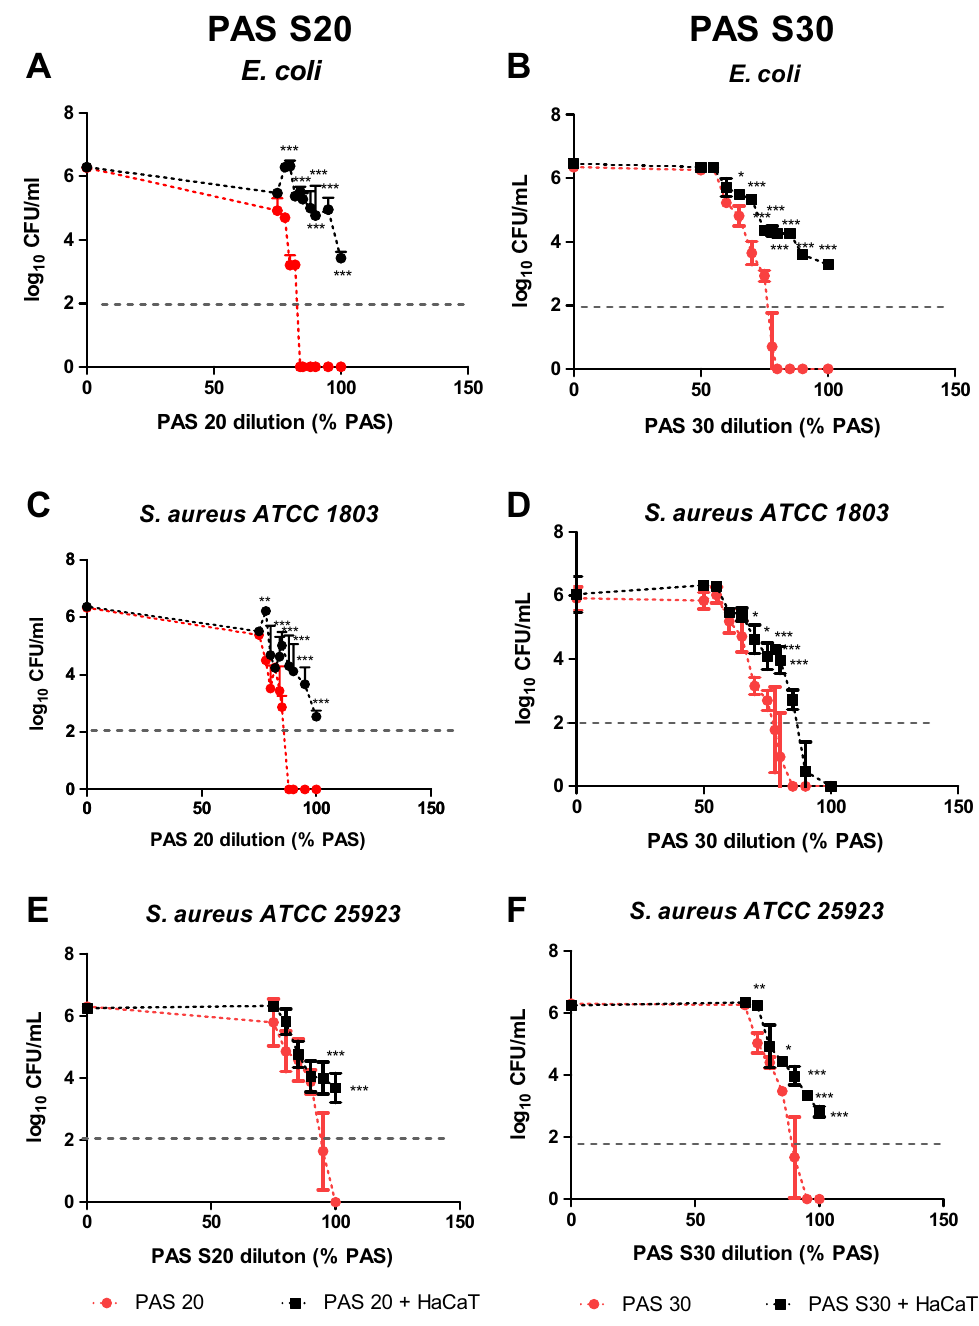
Figure 4. The antimicrobial efficacy of PAS 20 and PAS 30 within the co-culture model between HaCaT cells and E. coli or S. aureus and incubation with diluted PAS 20 or PAS 30 after 60 min contact time. ( A ) E. coli —PAS 20, ( B ) E. coli —PAS 30, ( C ) S. aureus ATCC 1803—PAS 20, ( D ) S. aureus ATCC 1803—PAS 30, ( E ) S. aureus ATCC 25923—PAS 20, ( F ) S. aureus ATCC 25923—PAS 30. The results are the mean ± S.D. of three determinations, limit of detection 2 log CFU/mL. Statistical significance is shown for comparison of bacteria + HaCaT cells (co-culture) incubated with PAS to only bacteria (no co-culture) incubated with PAS, with significance levels indicated as *** p < 0.001, ** p < 0.01, * p <